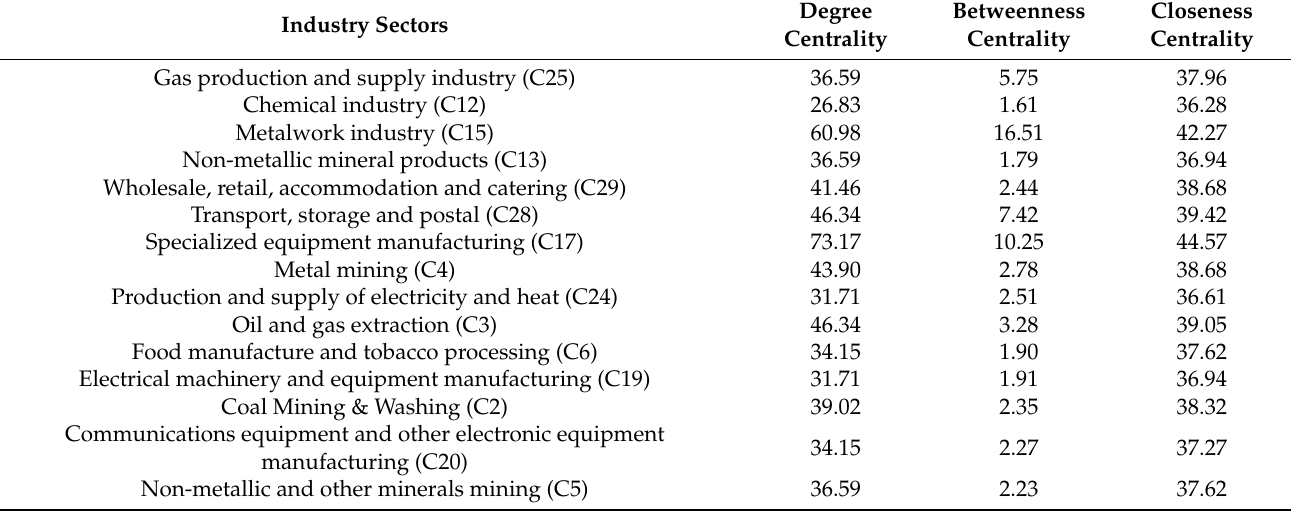
Table 3. Distribution of the values of centrality of 15 industrial sectors in Liaoning Province in